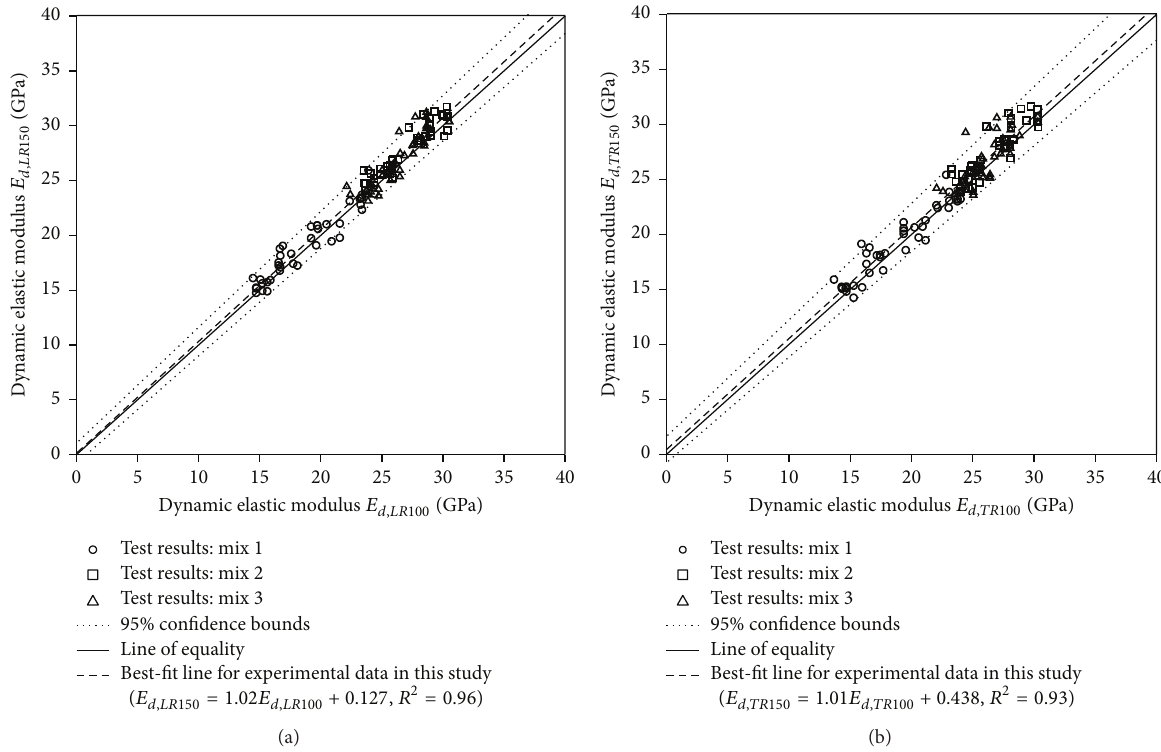
Figure 6: Comparison of resonance moduli from 100 by 200 mm and 150 by 300 mm cylinders: (a) 𝐸 𝑑,𝐿𝑅150 versus 𝐸 𝑑,𝐿𝑅100 and (b) 𝐸 𝑑,𝑇𝑅150 versus 𝐸 𝑑,𝑇𝑅100